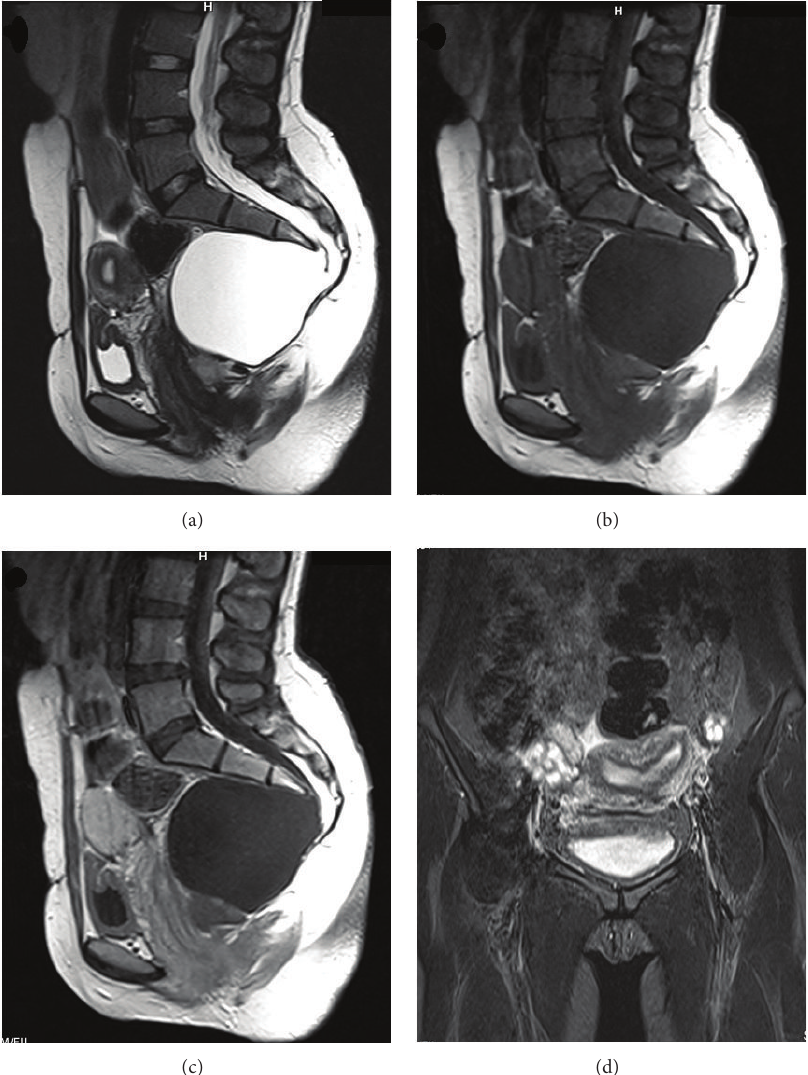
Figure2:SagittalT2-weightedMRIimagesofthethin-walledhyperintensityintheposterioroftheuterusandtherectum(a)andhypointense cystic lesion on T1-weighted images (b). The 4th and 5th sacral bones are not seen. In the posterior of the cyst, communication with spinal subarachnoid space is present. The contrast enhancement is not observed in sagittal postcontrast T1-weighted images (c). Conus medullaris ends at the level of the 4th lumbar spine. The distinct arcuate uterus is seen in the coronal T2-weighted images